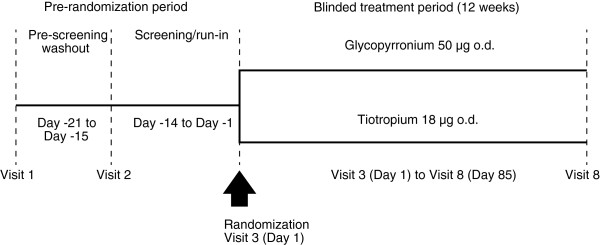
GLOW5 study design.